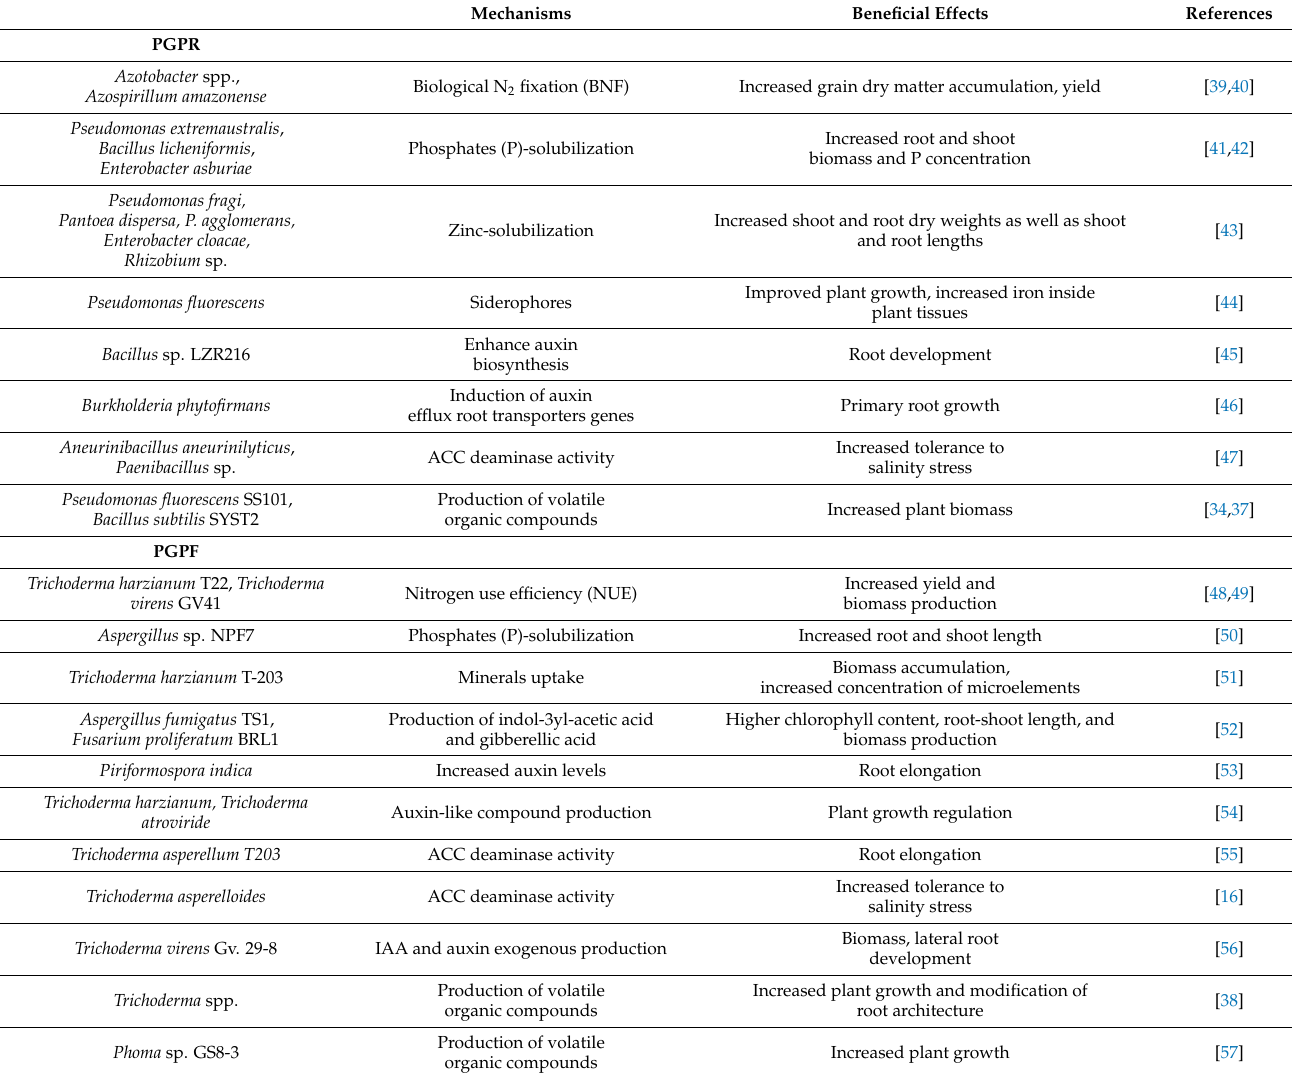
Table 1. Different mechanisms of plant growth promotion used by